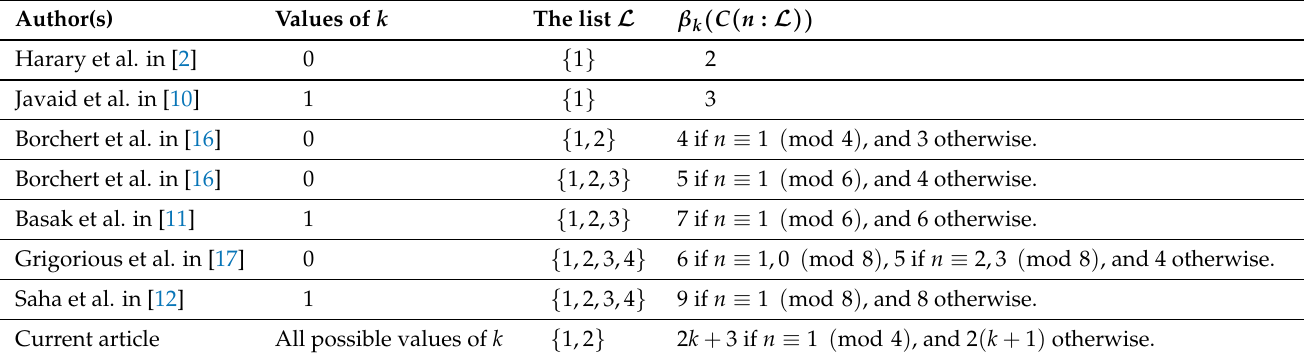
Table 1. Existing results and our results on β k ( C ( n : L )) for different values of k and L